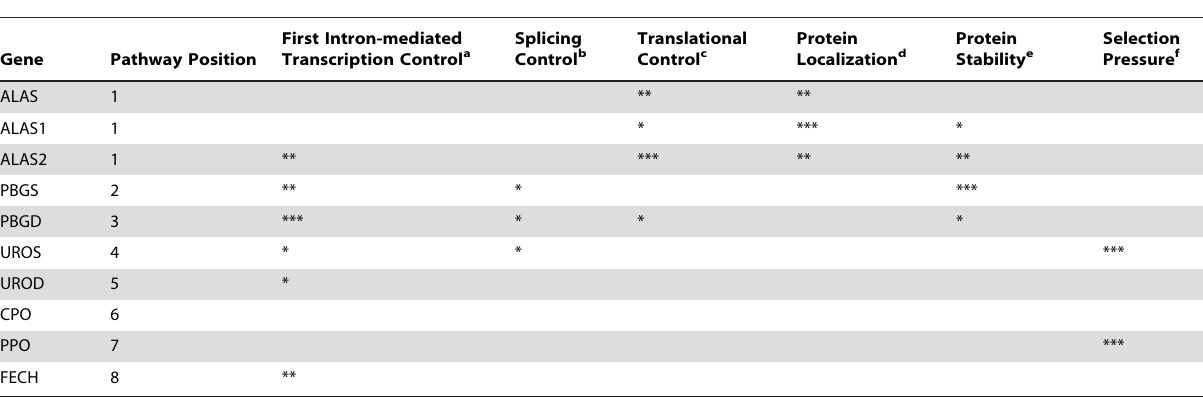
a Evolutionarily conserved DNase-hypersensitive sites in intron sequences. b IRE in intron-exon boundary that could potentially affect splicing. c IRE in 5 9 UTR,while binding IRP, could potentially inhibit protein translation. d HRM_t that could potentially block the import of enzyme to mitochondria while binding heme. e HRM_r that could potentially affect protein stability. f Genes with two highest v